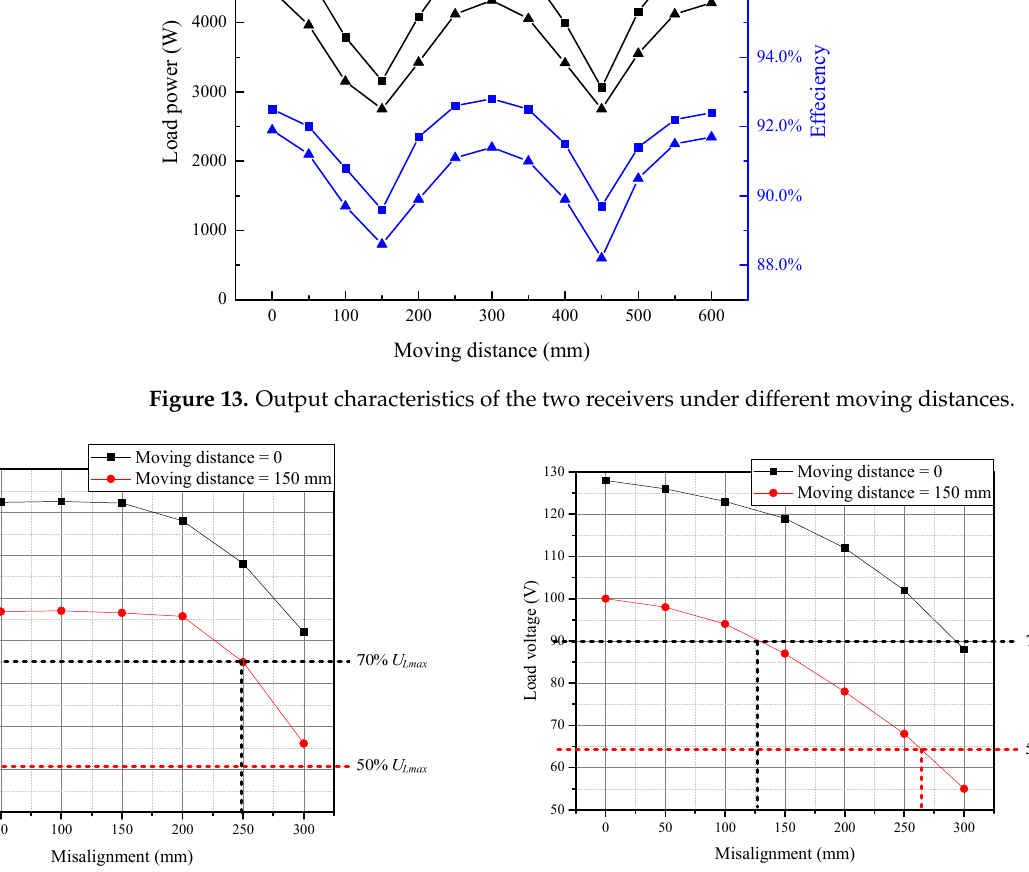
Figure 13. Output characteristics of the two receivers under different moving distances.